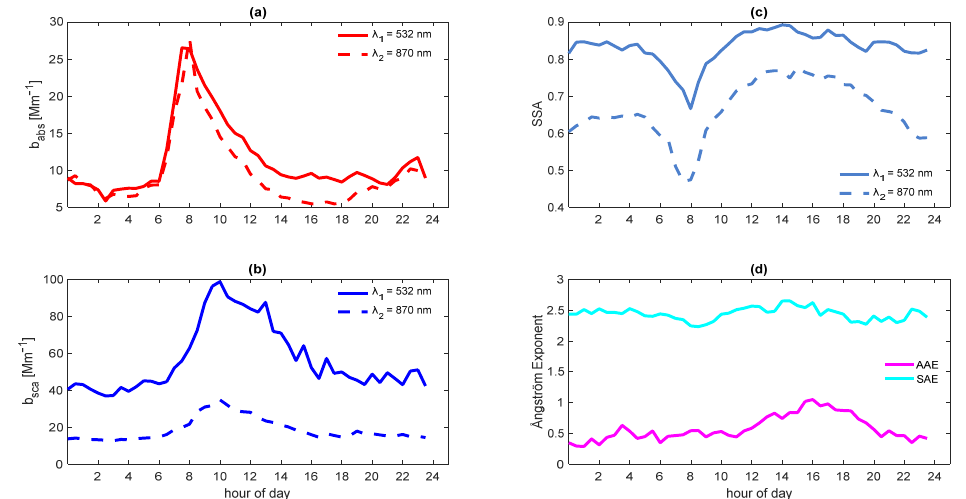
Figure 2. Particle optical properties. Average diurnal profile of ( a ) b abs at 532 and 870 nm, ( b ) b sca at 532 and 870 nm, ( c ) SSA at 532 and 870 nm, and ( d ) AAE and SAE between 532 and 870 nm. In 1997, Eidels-Dubovoi [62] reported similar trends for b abs and b sca in La Merced (Mexico City downtown) and Pedregal (southwest corner of Mexico City) at 530 nm, but with higher values: a maxima b abs of 310 Mm − 1 and a b sca of 650 Mm − 1 . Liñán-Abanto et al. [41] mentioned similar diurnal cycles of b abs at 870 nm at the same measuring site, with these reaching the maximum peak between 7:00 and 8:00. They reported an average b sca of 31.90 ± 29.80 Mm − 1 for a longer period. In 2003 and 2005, Baumgardner et al. [63] found similar behavior in optical properties at 550 nm, with a maximum b sca of 160 Mm − 1 and a b abs of 56 Mm − 1 .